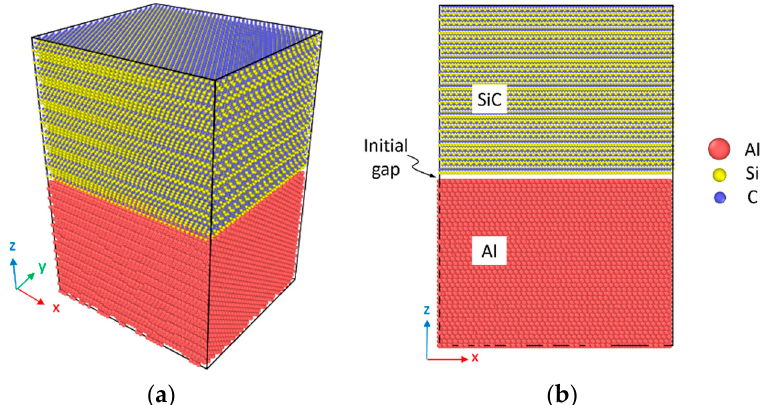
Figure 8. Model of the Si-terminated 6H-SiC/Al interface for the MD simulations. ( a ) Perspective view and ( b ) front view of the interdiffusion system.